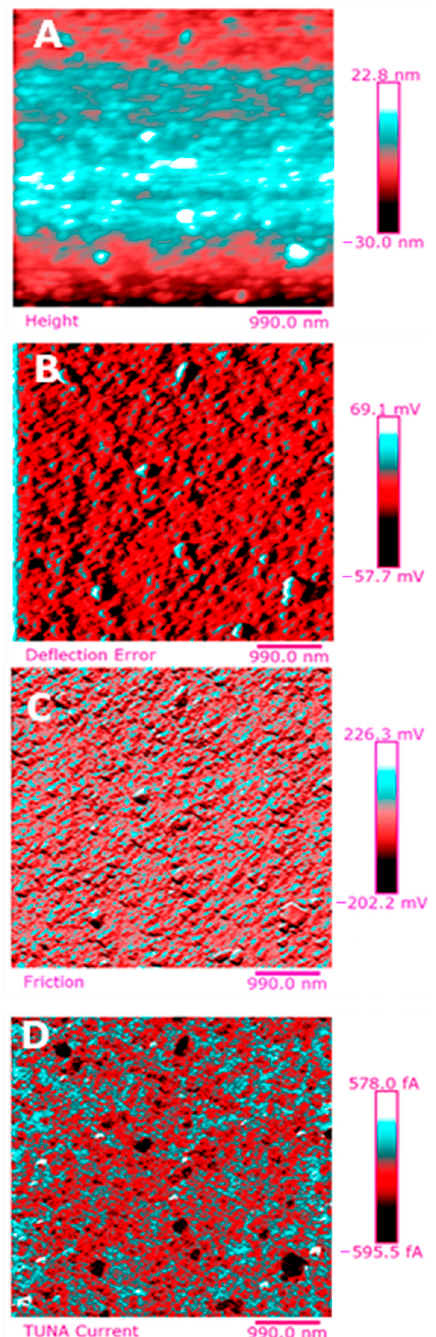
Figure 16. TUNA pictures (2D modality): ( A ) Height; ( B ) Deflection Error; ( C ) Friction; ( D ) TUNA Current of TCTBD+0.5%MWCNT.